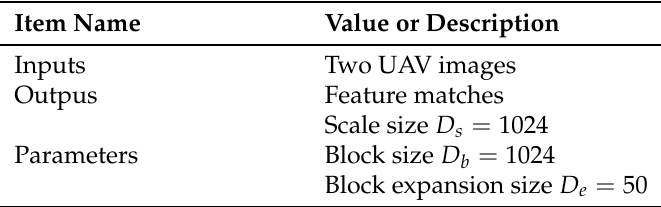
Table 2. The configuration of the tiling strategy.